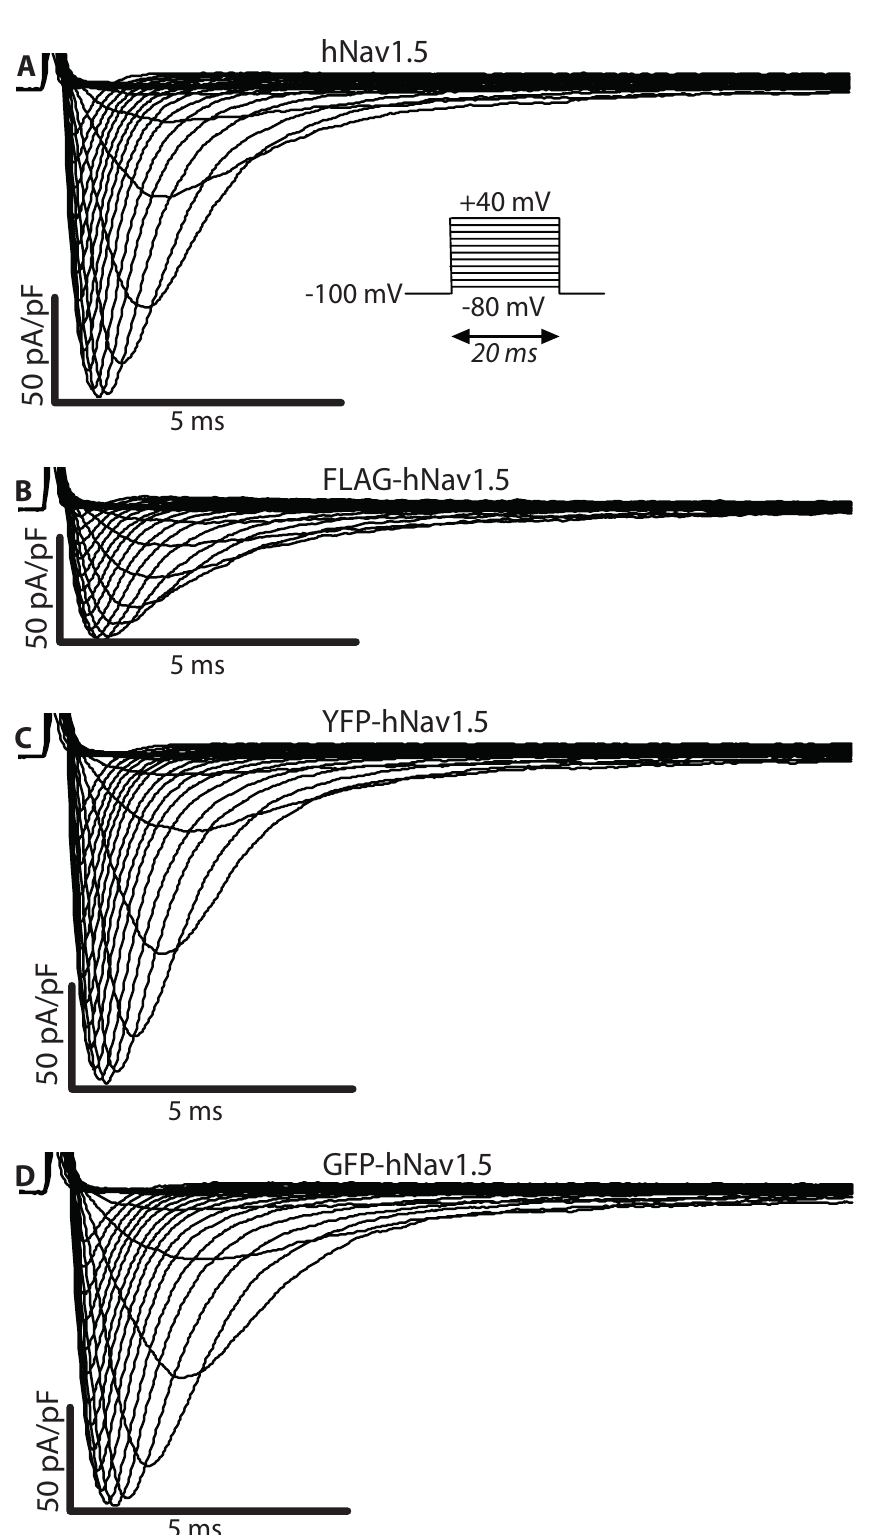
Figure 3. Representative sodium current (I cell. The same data for ( B )